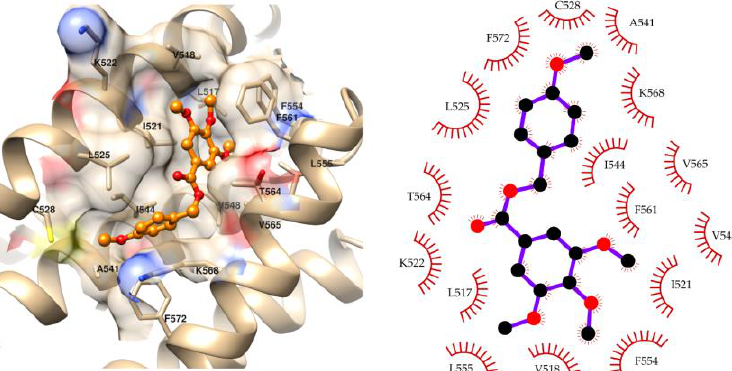
Figure 3. Predicted binding mode and ligand-receptor interactions for the compound 9 – CRM1 com- plex. The ligand is represented as orange balls and sticks. The receptor and its surface are colored as carbon: tan, nitrogen: blue, oxygen: red, and sulfur: yellow. The figure was produced with UCSF Chimera [35] and LigPlot+ [36].